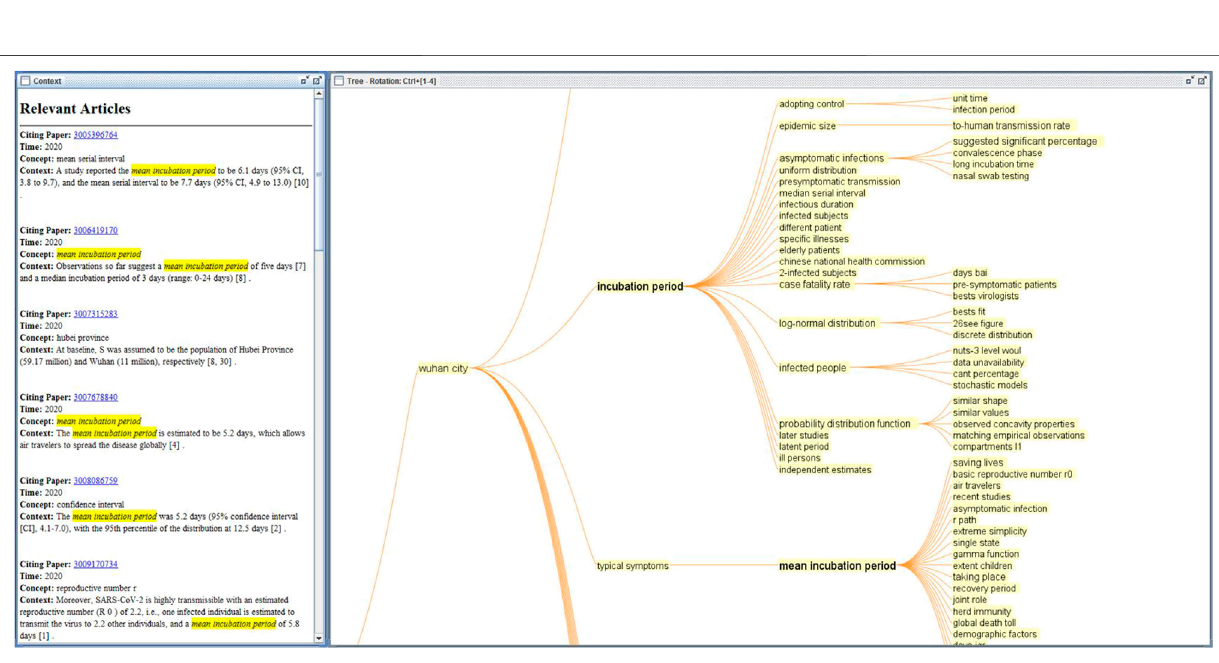
Frontiers in Research Metrics and Analytics |